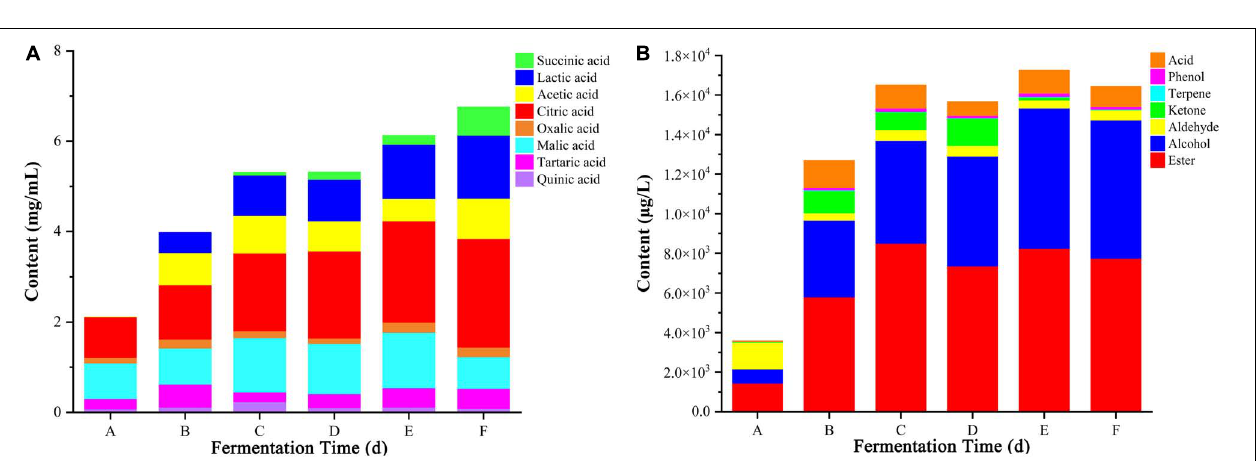
FIGURE 2 | Changes in the levels of 8 organic acids (A) and 7 types of volatile substances (B) across different fermentation stages. A, B, C, D, E, and F Represent samples collected on fermentation days 0, 3, 6, 9, 12, and 16,